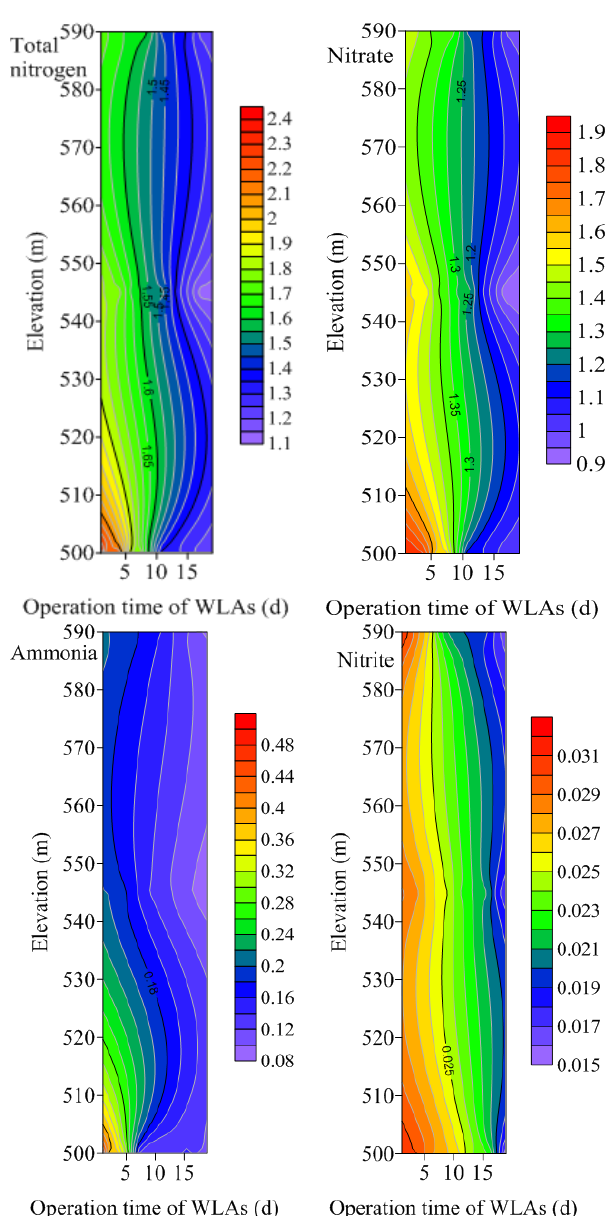
Figure 2. Variations in the concentration of total nitrogen, nitrate, ammonia, and nitrite during the operation of WLAs in the enhanced area.